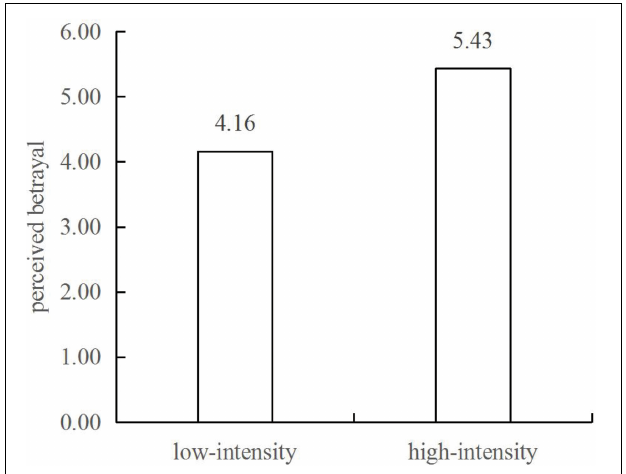
FIGURE 2 | The impact of algorithmic price discrimination on perceived